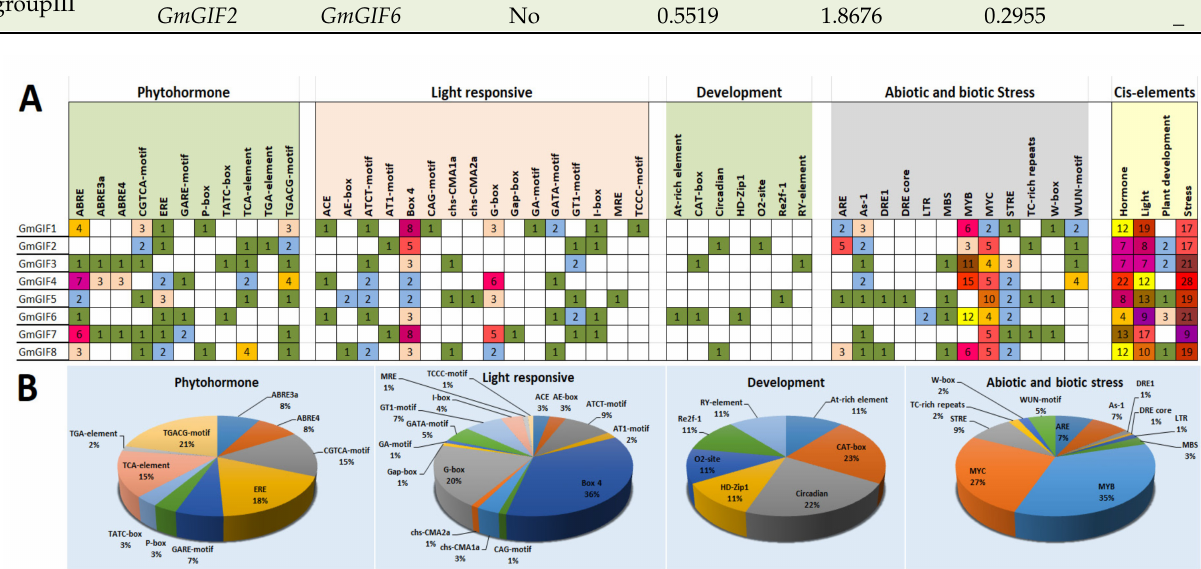
Figure 4. Analysis of a putative cis-acting element in the upstream region of GmGIF genes. ( A ) The numbers of distinct putative cis-acting factors discovered in the upstream region of GmGIFs in soybean. ( B ) Different grid colors showing GIF genes. A separate colored histogram is provided on the upper right side for the sum of the cis-acting elements in each group. Pie charts represent the ratio of each detected cis-acting factor in each